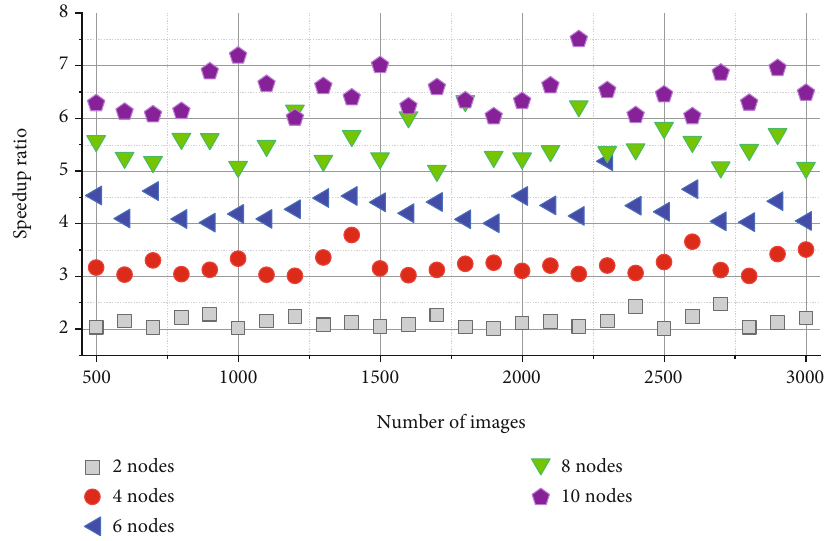
Figure 3: Comparison of speedup ratios.